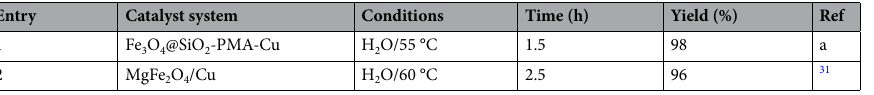
Table 4. Comparison of Fe 3 O 4 @SiO 2 -PMA-Cu catalytic activity with MgFe 2 O 4 /Cu for the 1,2,3-triazole click synthesis. All reactions were carried out with 1 mmol of styrene episulfide, phenylacetylene (1 mmol) and sodium azide (1.2 mmol). a The present method.